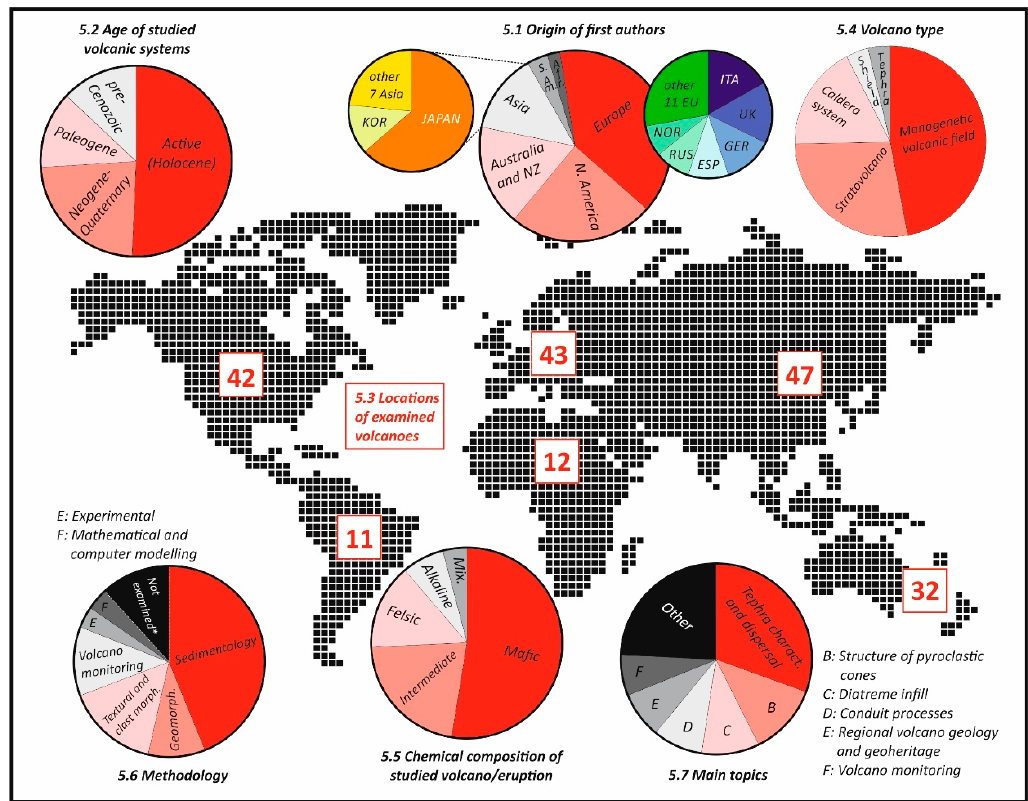
Figure 6. Graphical summary of the statistical analysis performed on articles published between 2014 and 2019 about phreatomagmatism, maars, and hydrovolcanism.